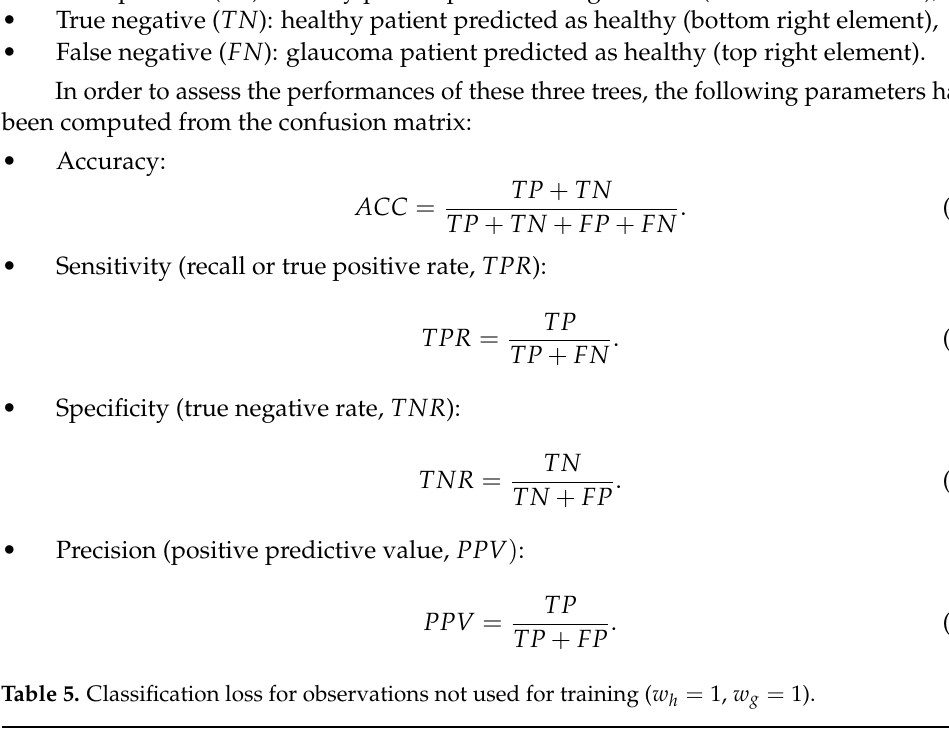
Table 5 gathers the classification loss for observations not used for training in deep decision trees ( ξ = 15) and shallower trees ( ξ = 3). The largest value of ξ for deep decision trees depends on the number of input features used, which in our case, were the seven asymmetry measurements performed in the six sectors and in the global average of the RNFL thickness. As can be seen, the classification loss decreases as the maximum number of splits is reduced, providing the best values for the metrics | ∆ | , ¯¯ ∆ and | ¯¯ ∆ | . The best values have been highlighted in bold in Table 5, and their corresponding decision trees and confusion matrices are shown in Figure 5. The representation of each model is a binary tree where each root node represents a single input variable (asymmetry feature) and a split point on that variable. The leaf nodes of the tree contain an output variable which is used to predict if the input corresponds to a healthy or a glaucoma patient. Regarding the confusion matrices, they provide four outcomes: